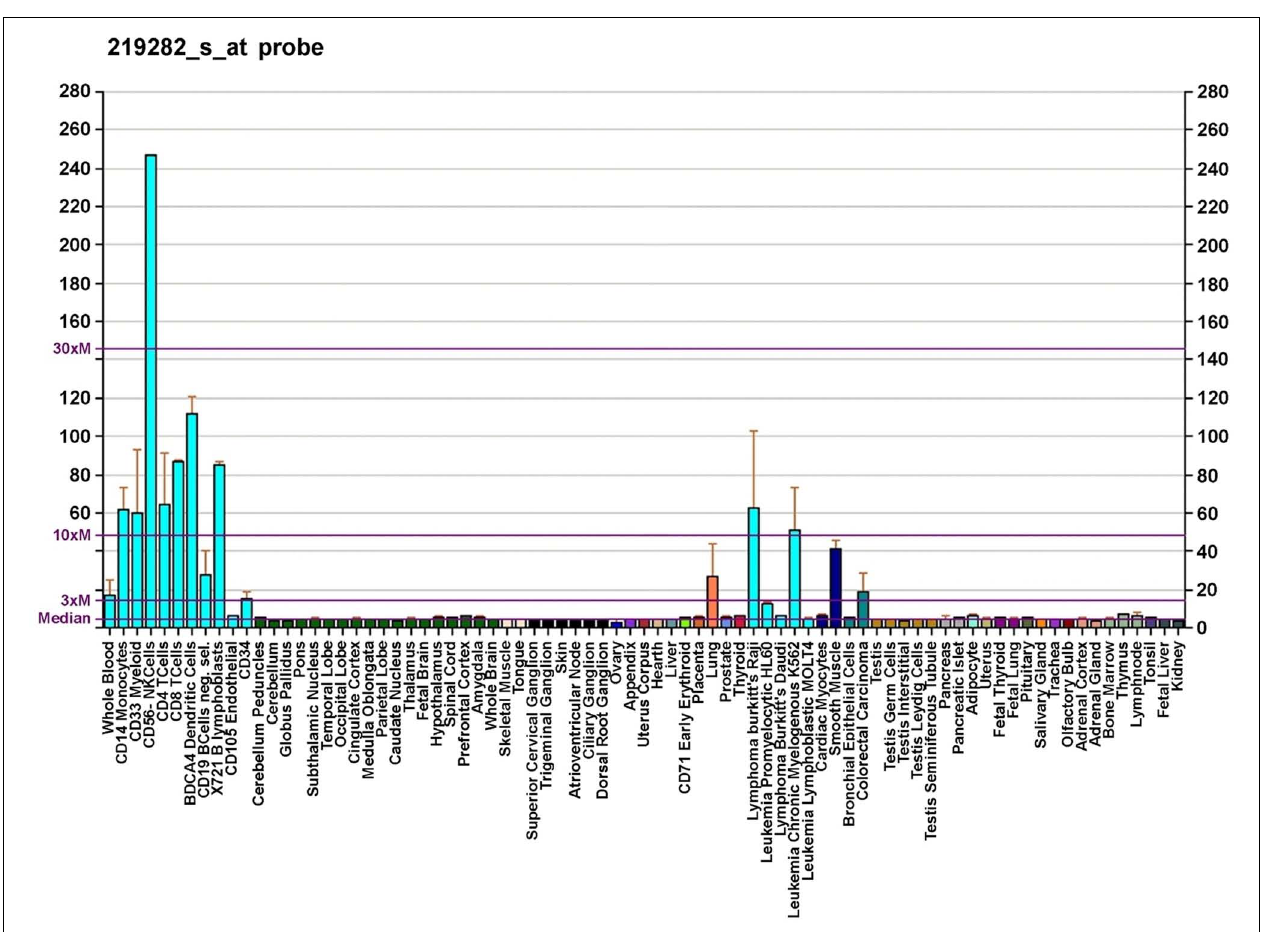
FIGURE 2 | Gene expression pattern of theTRPV2 gene. Diagram created by AndrewGNF based on data from Su etal.